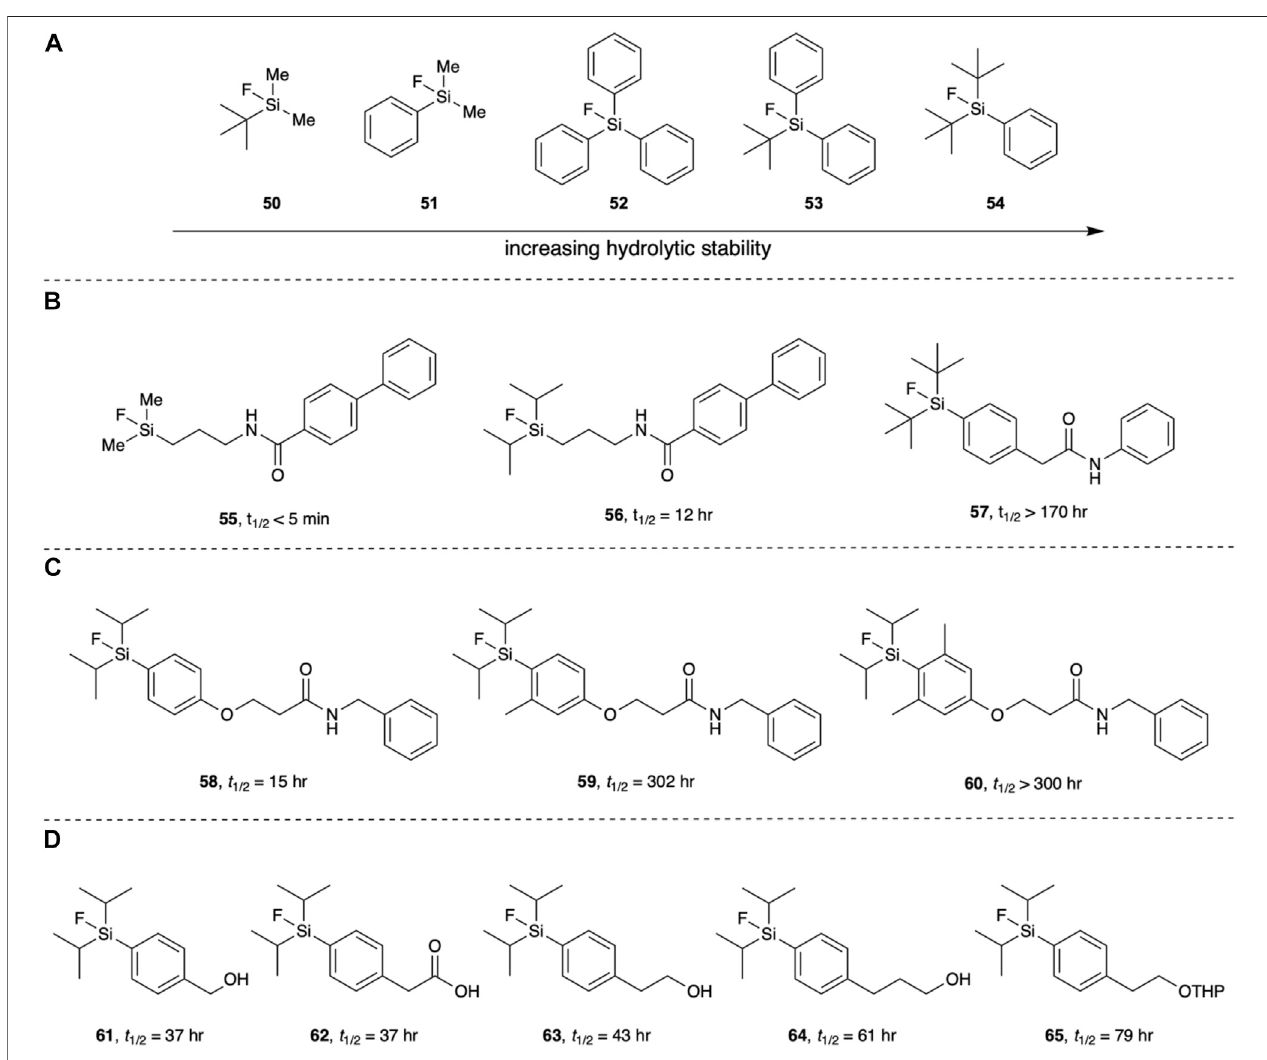
FIGURE7|(A) ThehydrolyticstabilityoftheSi-Fbondincreaseswithanincreaseinsterichinderancearoundthesiliconatom. (B) Thehydrolytichalf-lifeisaffected by the silicon substituents. (C) The addition of methyl groups ortho to the aryl silicon increases hydrolytic stability. (D) Para substituents relative to the silicon atom also impart a subtle effect on the hydrolytic stability of the Si-F bond. All stated half-lives were measured in a 2:1 solution of MeCN:aqueous buffer (pH 7).